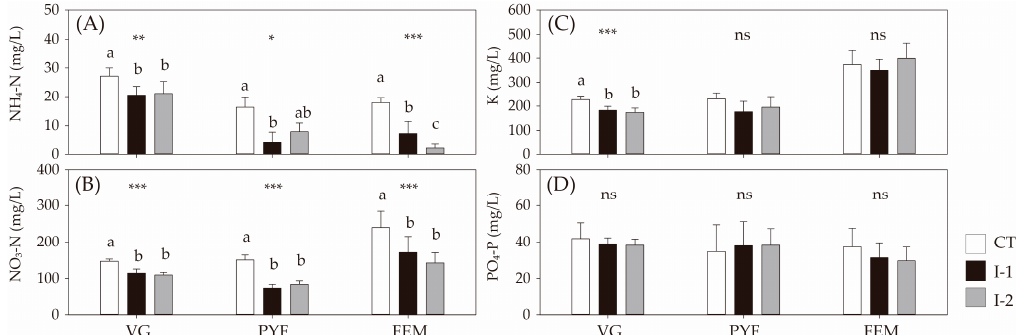
Figure 3. Mean ( + sd) of ( A ) NH 4 -N, ( B ) NO 3 -N, ( C ) K, and ( D ) PO 4 -P concentrations of the hydroponic solutions measured during VG, PYF, and FEM from the three di ff erent nutrient treatments in Experiment I. Bars of di ff erent colours represented di ff erent nutrient treatments. Statistical significances tested with one-way ANOVA were denoted by asterisk: p < 0.05 *, p < 0.01 **, p < 0.001 ***. Codes and details for the experimental treatments refer to Table 1.